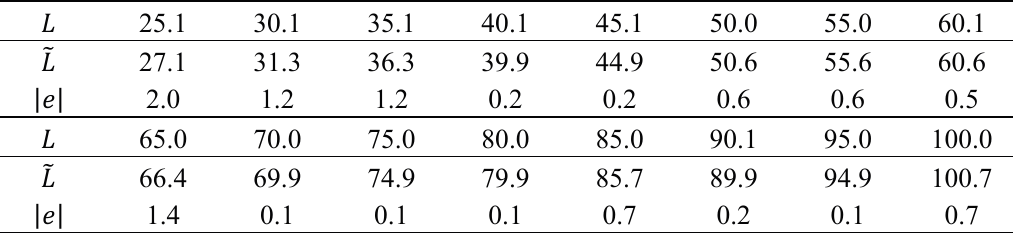
Table 1. Experiment results in